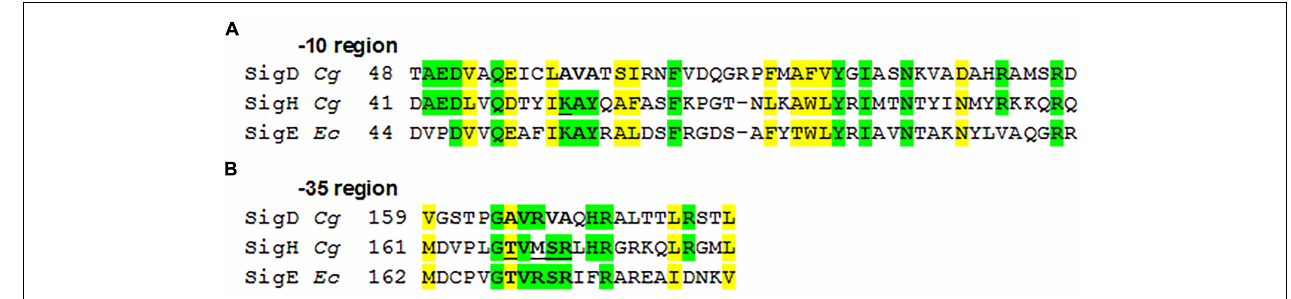
FIGURE 5 | Alignment of the σ AA sequences binding promoter –35 and –10 elements in C. glutamicum . E. coli σ E , which was analyzed using its crystal structure (Lane and Darst, 2006; Campagne et al., 2014), is aligned for comparison. The AAs which are supposed to interact with the –10 (A) and –35 (B) elements (Lane and Darst, 2006; Campagne et al., 2014) are in bold. The σ H AAs which we replaced with the corresponding AAs from σ D by mutagenesis are underlined. Identical AAs are shown in green, similar in yellow; Cg , C. glutamicum ; Ec , E. coli .